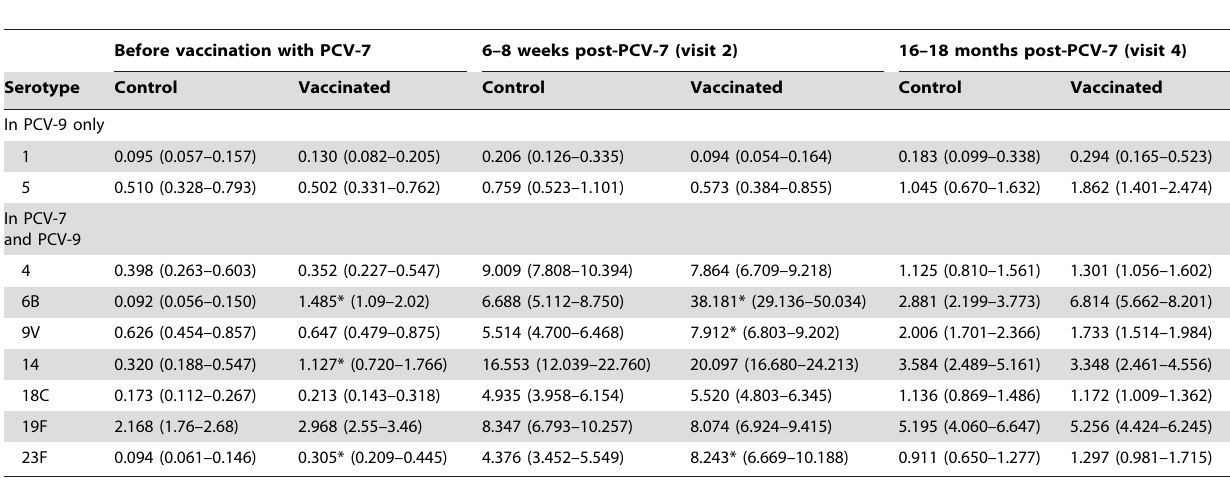
Table 1. Geometric means (95% CI) of IgG antibody concentrations ( m g/mL) before and after boosting with PCV-7 in the group that previously had placebo (Control) or PCV-9 (Vaccinated).